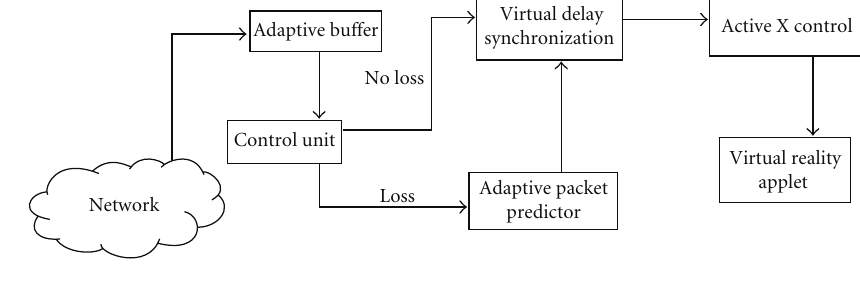
Figure 6: Client functional description.